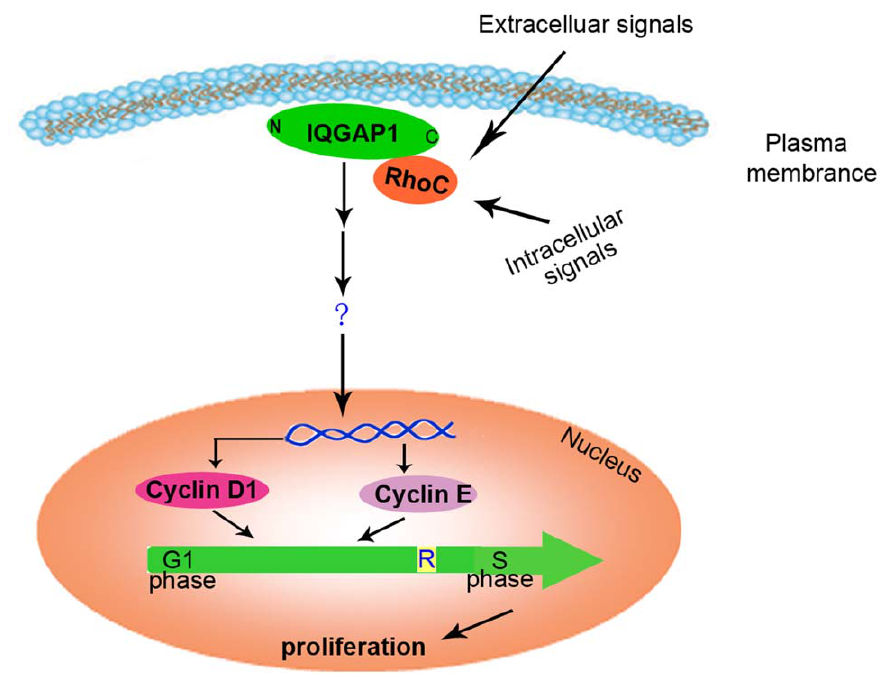
Figure 6. The schematic diagram of crosstalk between RhoC and IQGAP1 in gastric cancer. When RhoC is stimulated by extracelluar or intracelluar signals, it binds with the scaffold protein IQGAP1, influences the expression of cell cycle-related proteins such as cyclin D1 and cyclin B, affects G1-S transitions in the cell cycle, and then causes the change in cell proliferation. The signal transduction event through which IQGAP1 affects the expression of cyclin still needs to be